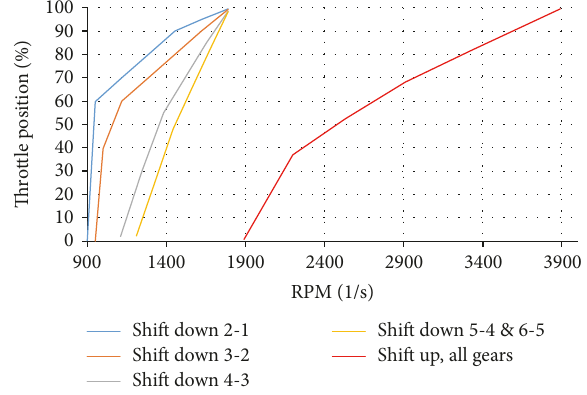
Figure 9: Gear shifting